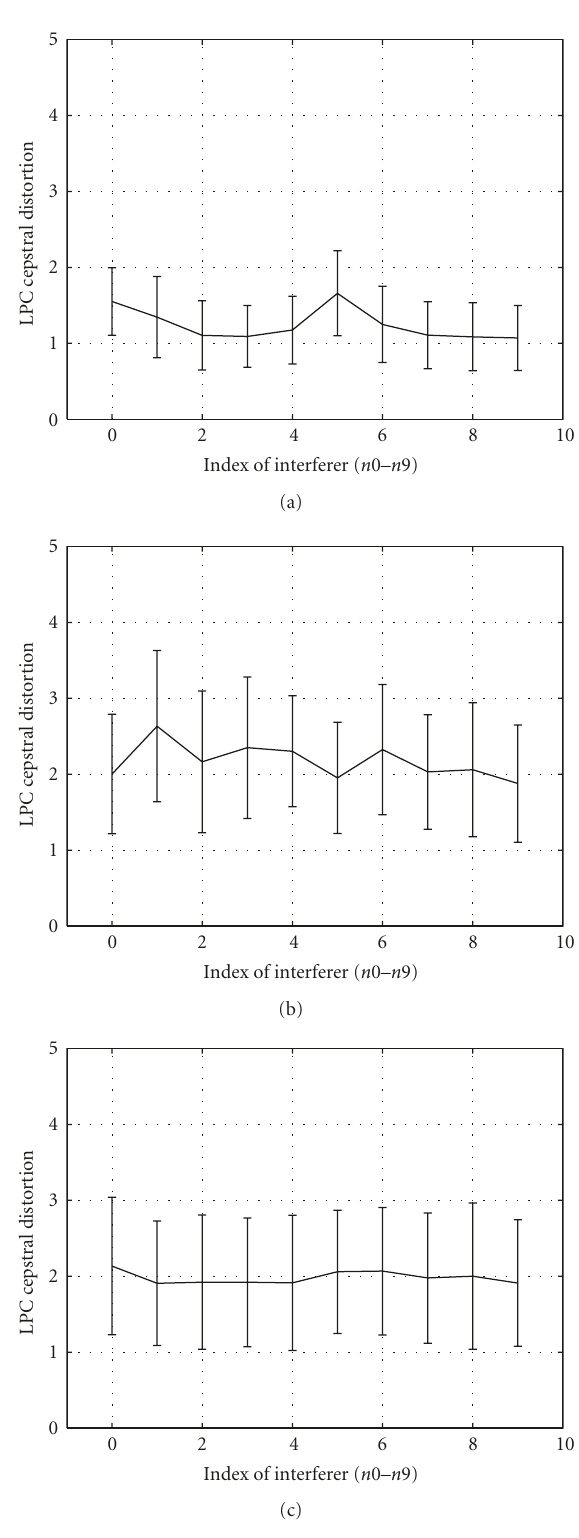
Figure 8: LPC cepstral distortions of (cid:30) v 8 estimates from beam- forming (a), CASA (b), and CASA-EB (c). As in Figures 6 and 7, the horizontal axes in the graphs specify the test mixture by the index of the interferer. The value plotted is the mean LPC cepstral distortion over the duration of the input mixture, v 8 + nx , nx ∈ { n 0, n 1, ... , n 9 } ; the error bars show the standard